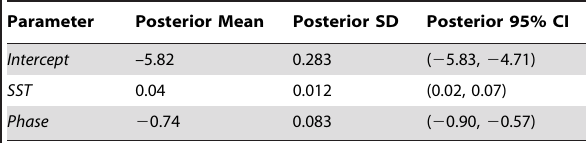
activity loggers and environmental data, which could be useful for the increasing number of tracking studies of seabirds around the world. We provide a specific example of how animals can adjust how animals can use strong and predictable environmental cues, such as the lunar cycle, to inform behavioral decisions [44,45].